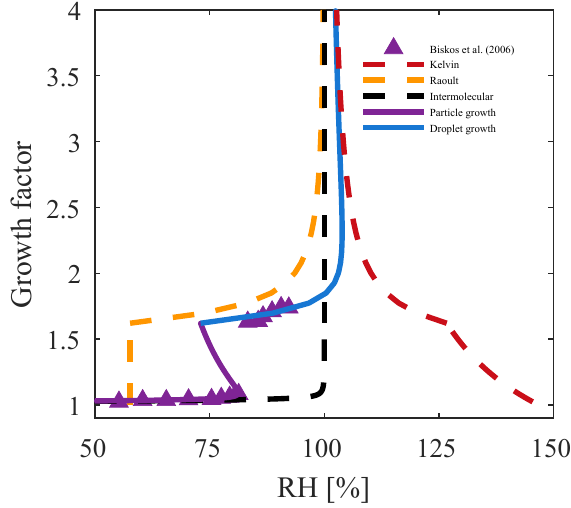
Figure 5. The evolution of the individual terms in Eq. (10) are shown for a solvating 5nm NaCl particle. For such small particles the Kelvin term dominates, yielding an activation barrier, as illus- trated by the inflection in the layer growth (magenta) curve. One also observes that the Raoult term (yellow curve) changes only af- ter the solid particle dissolves ( R DRH ) and that the intermolecular interactions are very short range (black